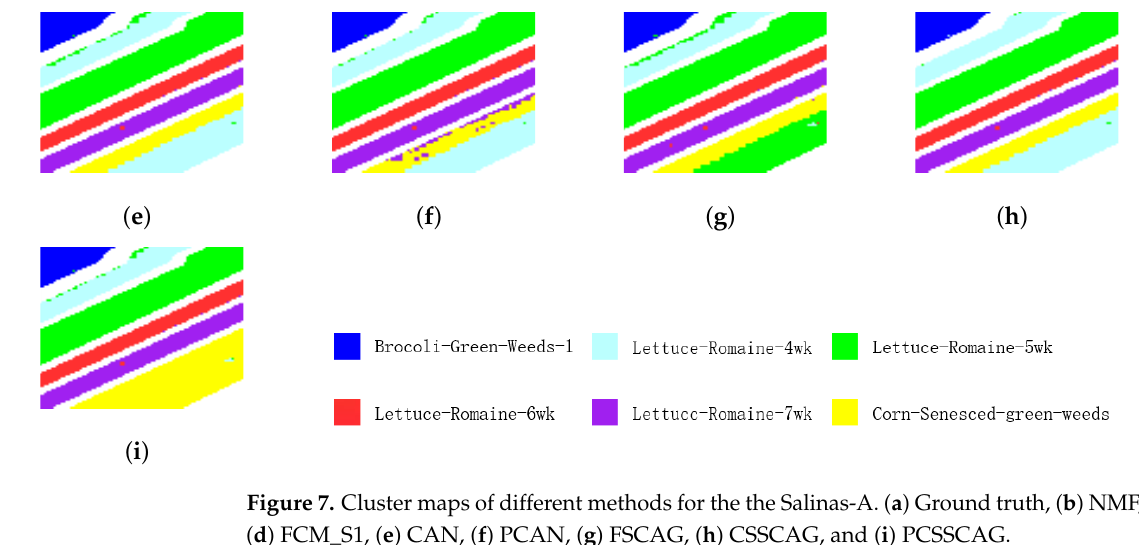
Figure 7. Cluster maps of different methods for the the Salinas-A. ( a ) Ground truth, ( b ) NMF, ( c ) FCM,